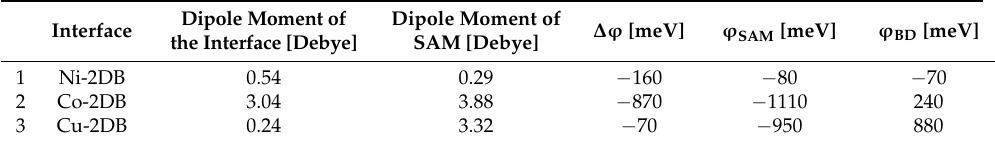
Table 2. Dipole moment, work function shift, molecular and bond dipole contributions of ∆ ϕ and charge transfer value for M-2DB